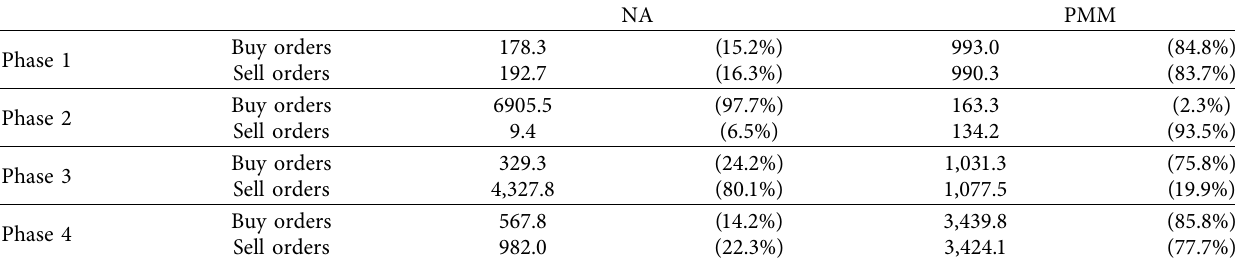
Table 4: Numbers and proportions of NA’s orders and POMM’s orders in the order book that matched a new order.